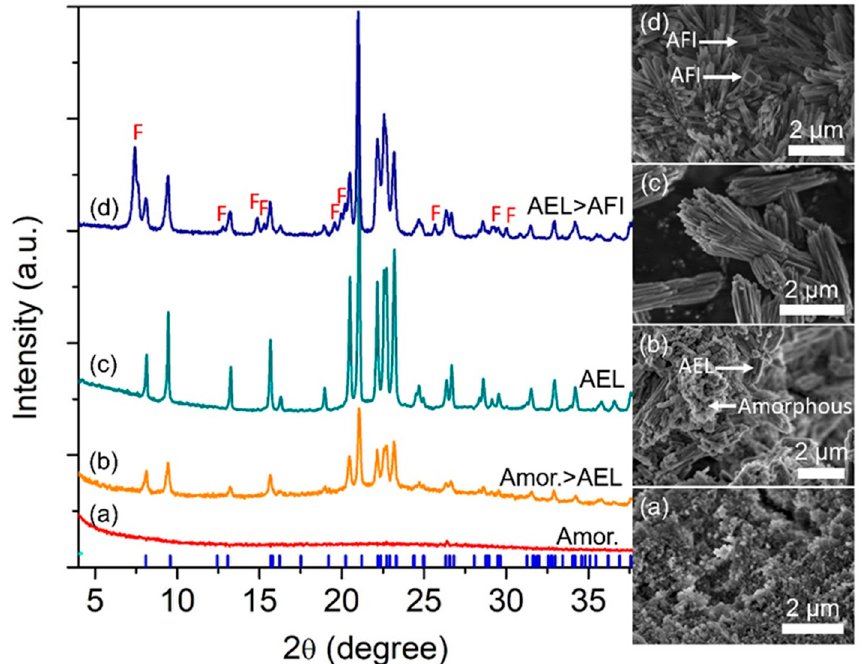
Figure 1. XRD patterns and FESEM images of ( a ) E-1, ( b ) E-2, ( c ) E-3 and ( d ) E-4 samples ionother- mally heated at 150 °C for 110 h, 120 h, 133 h and 200 h, respectively. F denotes the presence of AFI crystalline phase. The theoretical XRD peak positions of the AEL phase are shown as vertical blue lines.